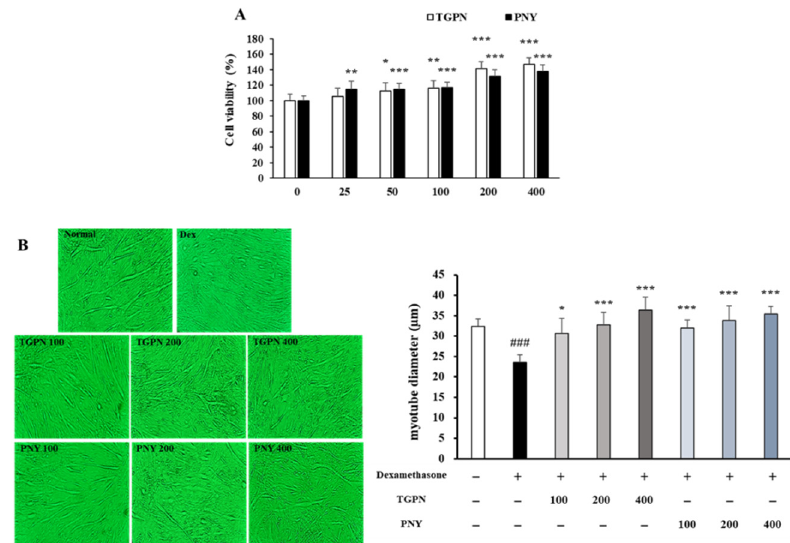
Figure 2. Effect of TGPN and PNY on cell viability and myotube atrophy in C2C12 myotubes. ( A ) Cell viability of TGPN and PNY. C2C12 myotubes were treated with various concentrations (100, 200, 400 μ g/mL) of TGPN and PNY on day 7 of differentiation for 48 h. ( B ) Quantification of C2C12 myotube diameter and 400x magnification images of myotubes. 50 μ M dexamethasone and TGPN or PNY (100, 200, 400 μ g/mL) were co-treated on day 7 of differentiation for 48 h. The data are expressed as mean ± SD. ### p < 0.001 versus normal, * p < 0.05, ** p < 0.01, *** p < 0.001 versus untreated control or Dex.